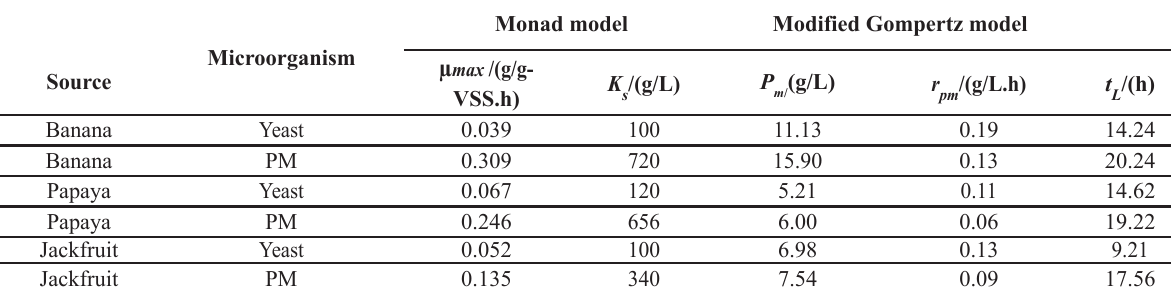
Table 6: Predicted kinetic parameters obtained from Monad and modified Gompertz